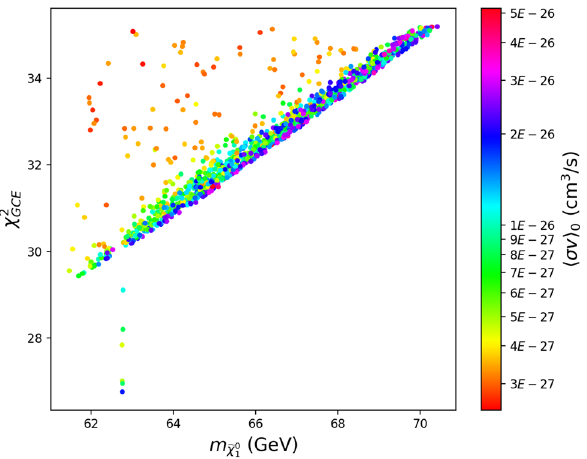
versus χ 2 with GCE 1 χ 2 represented by colors, where a solid line indicating m A GCE 2 is provided